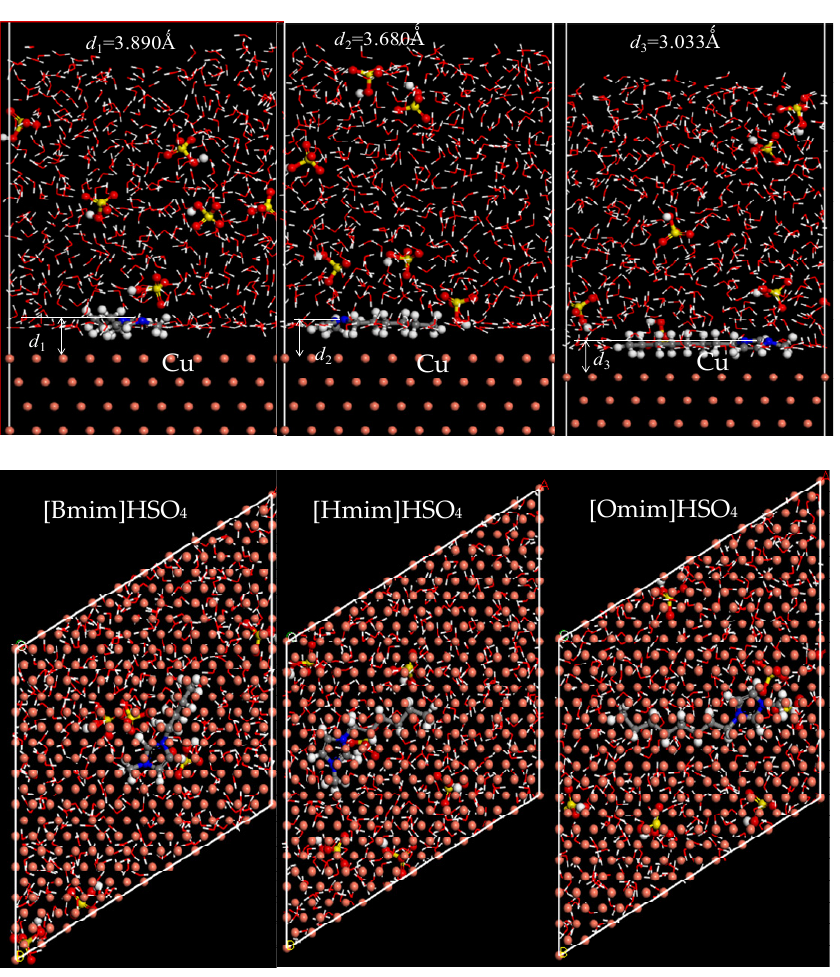
Table 3. Adsorption energies (kcal/mol) of inhibitors on the Cu(111) surface from an MD simula- tion in a vacuum.